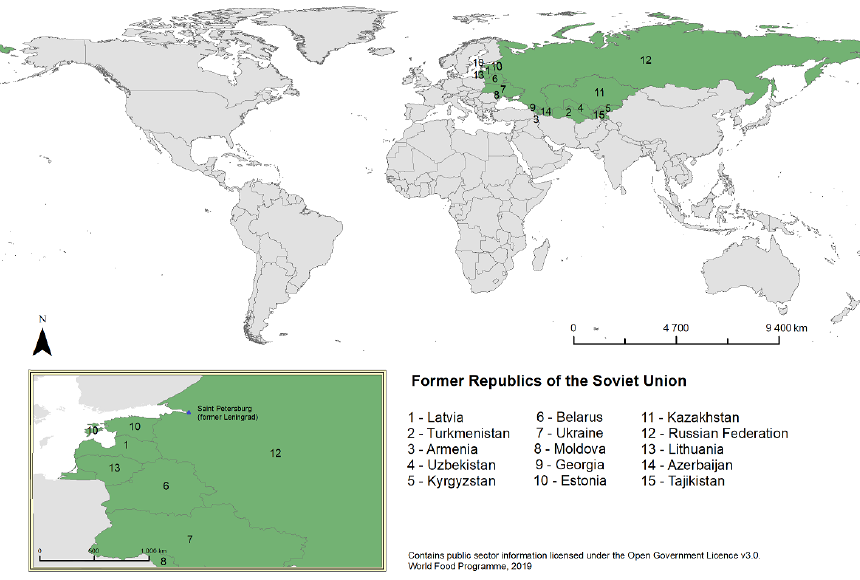
Figure 8. The studied region on the world map today.